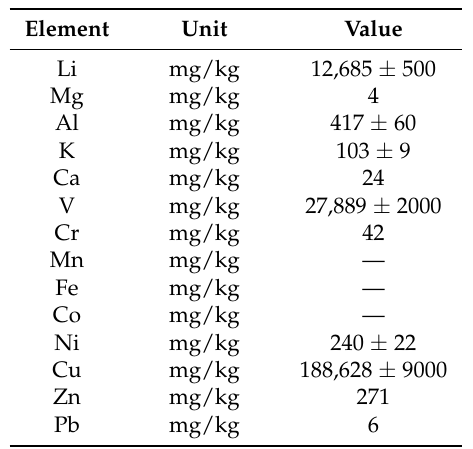
Figure 2. ( a , c ) Induced magnetic moment measurements using SQUID-based MPMS. ( b , d ) Induced magnetic field maps using the atomic magnetometer setup. ( a , b ) measurements of healthy and broken cells. The inset illustration in ( a ) shows the induced magnetic moment values scaled to a background magnetic field of µ 0 H = 40 µ T. The grey area in ( c ) shows the variations between cell measurements using SQUID-based MPMS and the inset shows the hysteresis loop at small fields. The atomic magnetometer measurements in ( d ) show the induced magnetic field maps of a healthy cell after degaussing and magnetizing. Table 1. Elemental content of the cell measured with inductively coupled plasma mass spectrometry. The mass of the cell is 0.045 g. Mn, Fe, and Co could not be detected above the detection